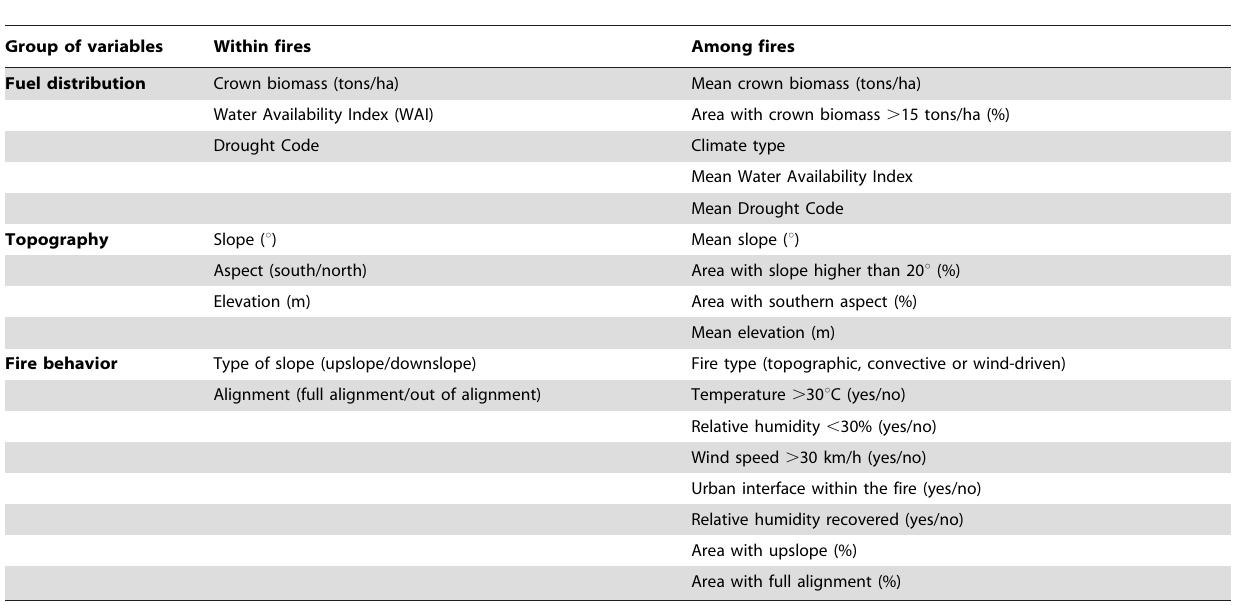
Table 1. I ndependent variables of the three groups considered at the two levels: fuel distribution, topography and fire behavior, analyzed within and among